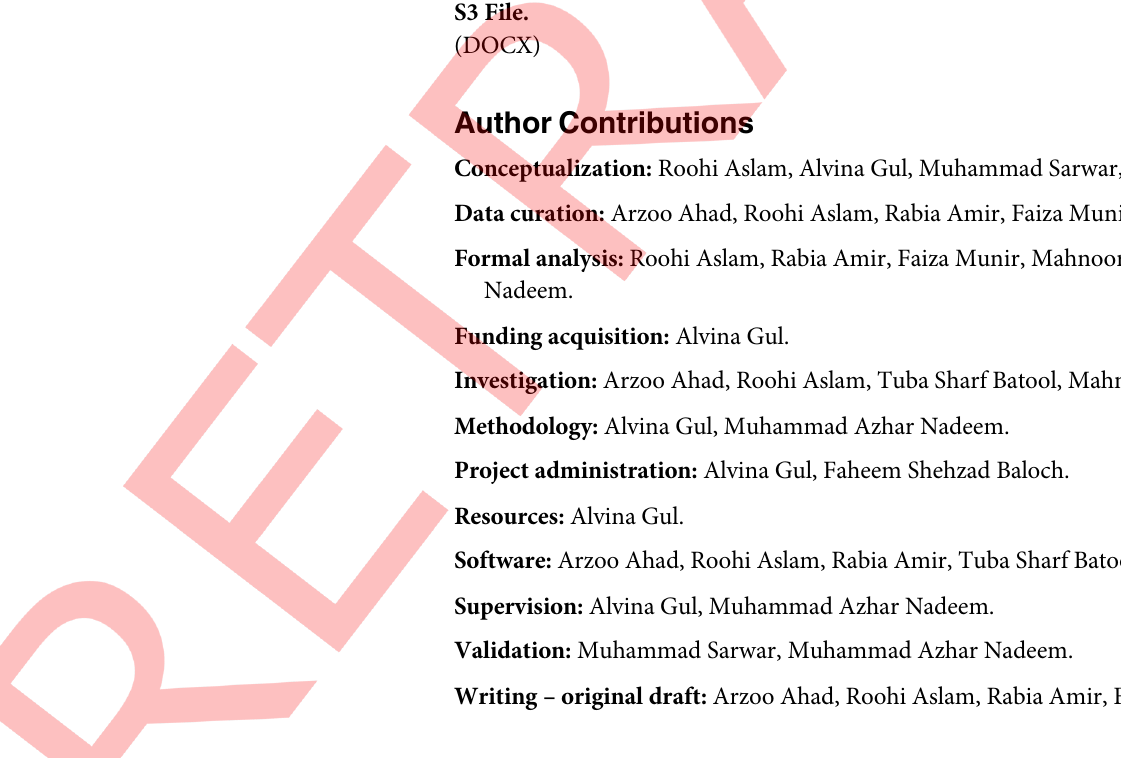
S1 Table. bZIP transcription factor from selected monocots. S2 Table. BBR transcription factor from selected monocots. S3 Table. BZR transcription factor from selected monocots. S4 Table. Triticum aestivum bZIP subcellular localization. S5 Table. Triticum aestivum BBR subcellular localization. S6 Table. Triticum aestivum BZR subcellular